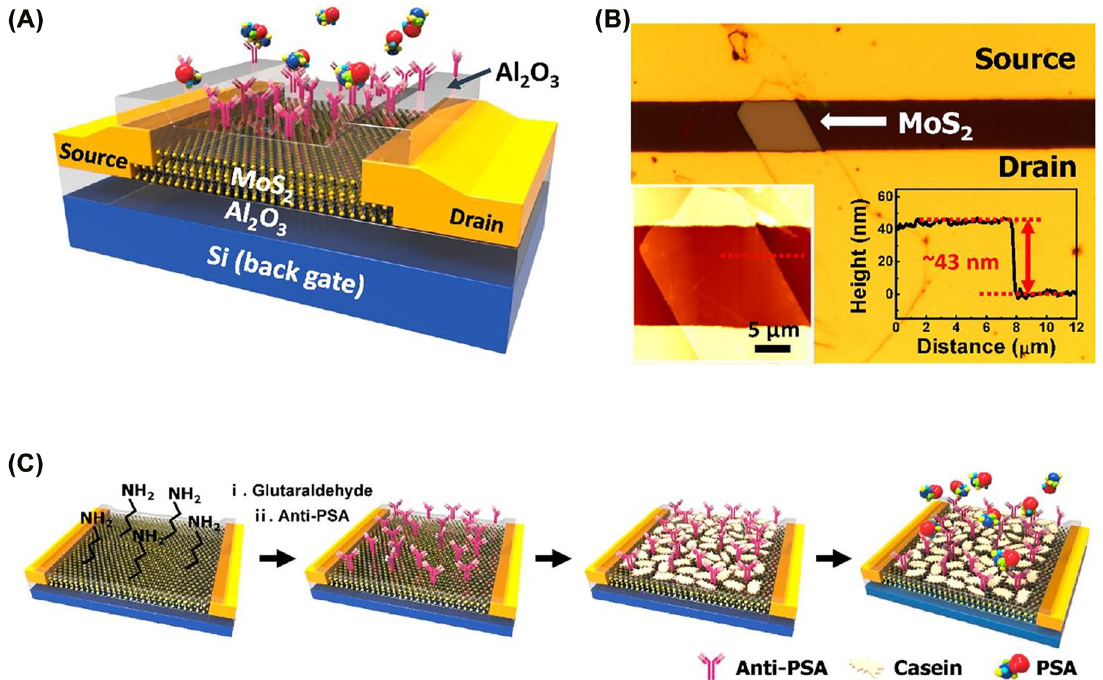
based PoC dvices for biological sample analysis. Reproduced with permission from [148] Figure 3: Schematic representation of MoS 2 Copyright @The American Chemical Society